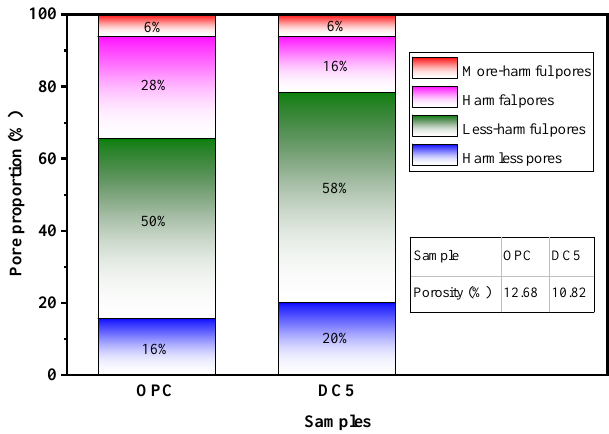
Figure 14. Pore proportions of samples.